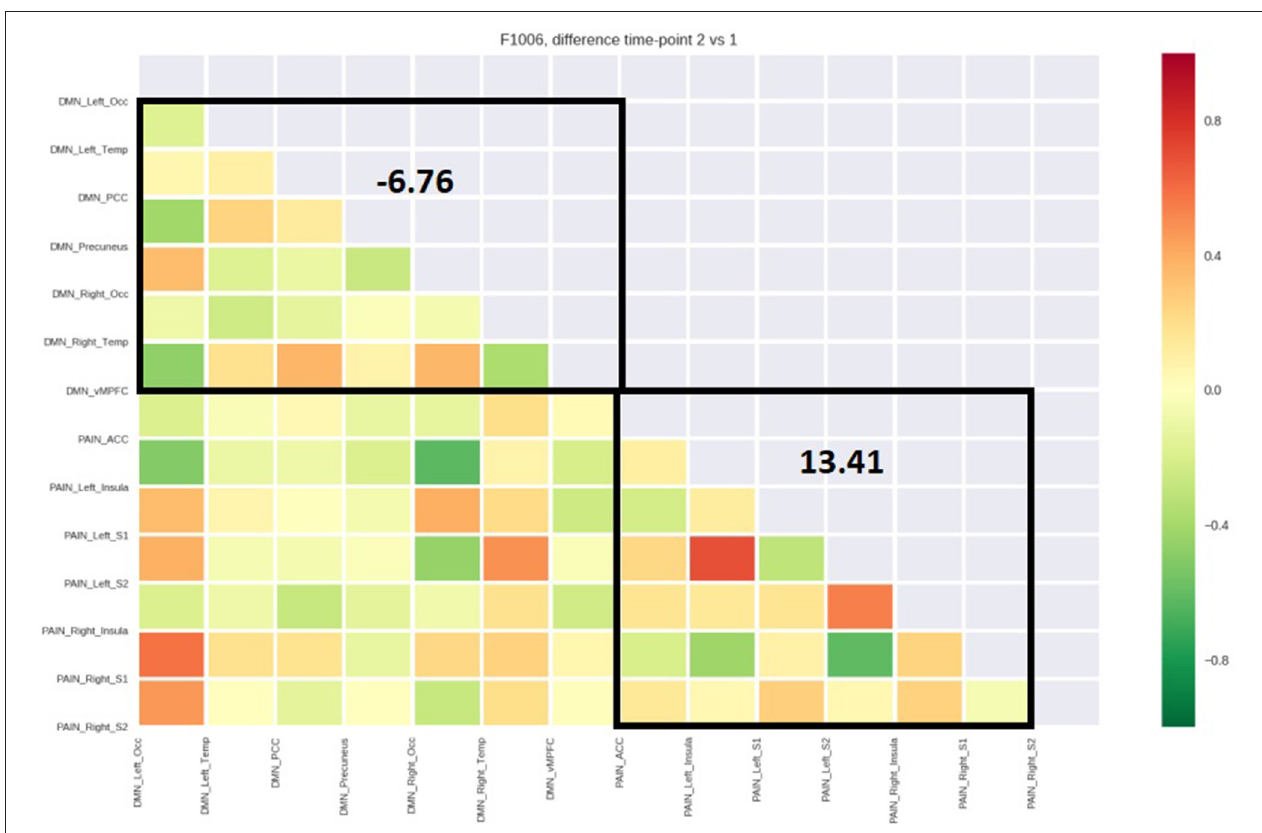
FIGURE 6 | Matrix difference T2–T1 of the fifth patient and DMN and PN average